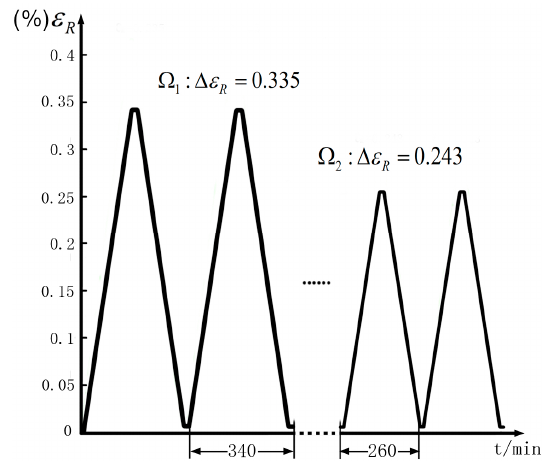
Figure 9. Resistance strain curve in certain thermal load conditions.